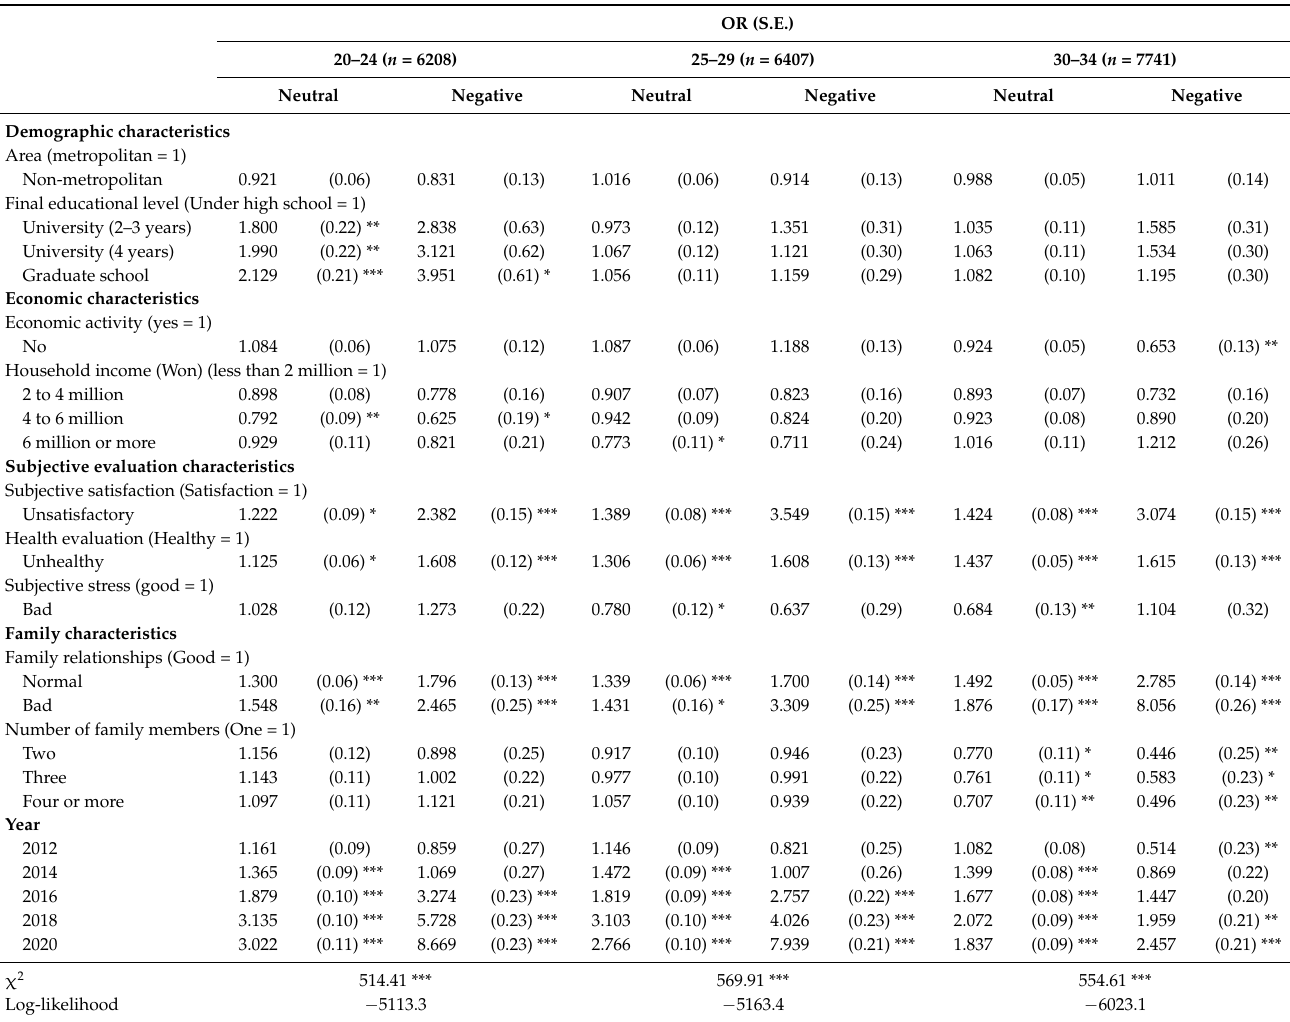
Table 3. Factors affecting marriage intentions of unmarried women (aged 20–34) 1